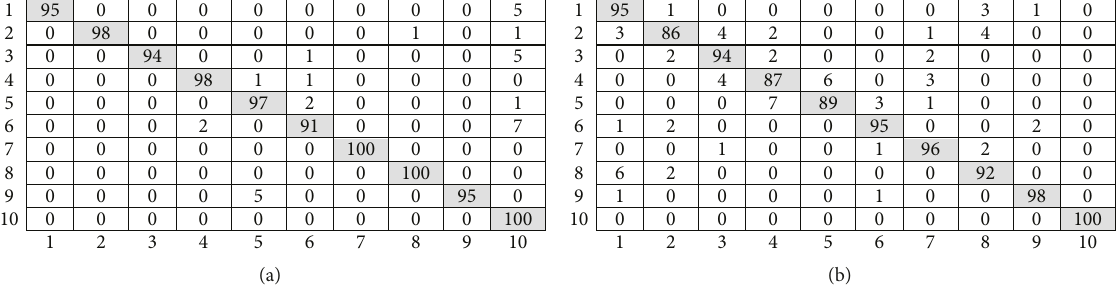
Figure 14: Confusion matrix of (a) proposed approach and (b) FEMD-based approach.